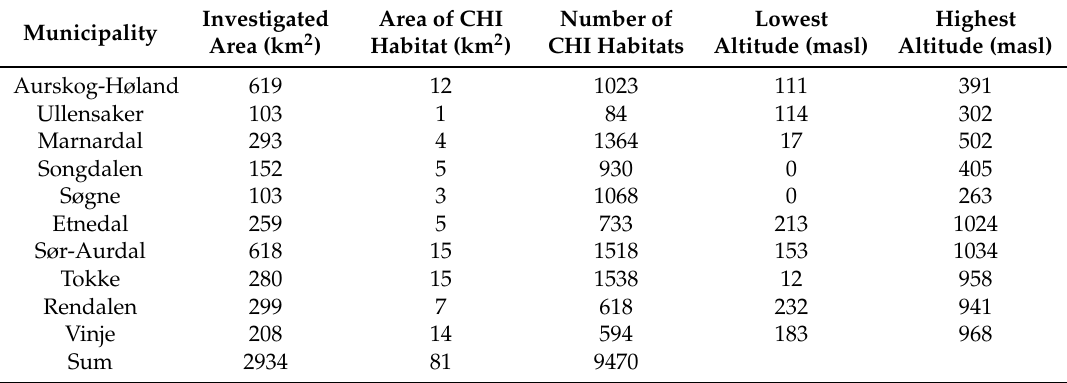
Figure 1. The 10 study areas (municipalities) in southern Norway included in this study: Rendalen, Etnedal, Sør-Aurdal, Ullensaker, Aurskog-Høland, Vinje, Tokke, Marnardal, Songdalen, and Søgne. The dark grey area constitutes the main forestry region of Norway. Table 2. Area data for the 10 study areas (municipalities) included in this study. masl = metres above sea